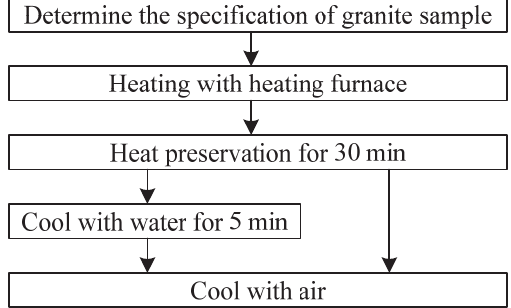
Figure 1: Experimental set